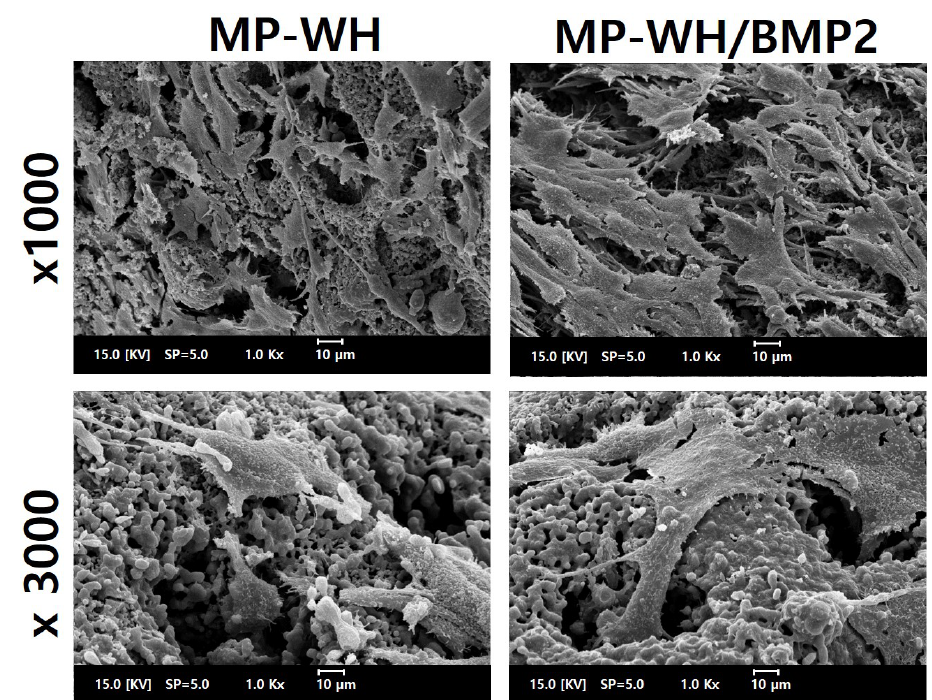
Figure 7. SEM images of cellular adhesion and growth. Cells are cultured on the surfaces of the synthesized MP-WH and MP-WH/BMP2 granules, and their morphologies are observed using SEM after three days in culture.